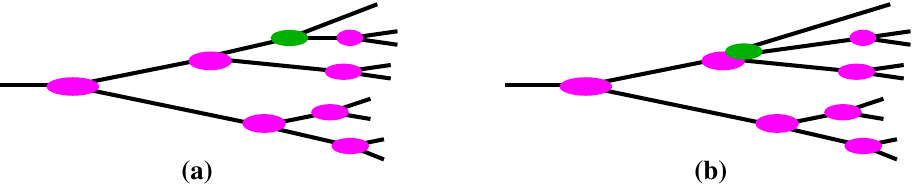
Figure 3 . An example of an in-medium shower like (cid:12)gure 1b, but here depicting the ambiguity of the longitudinal position of each splitting by an oval that represents the formation length. (a) shows the case where there is no interference between splittings; (b) shows a case where two consecutive splittings